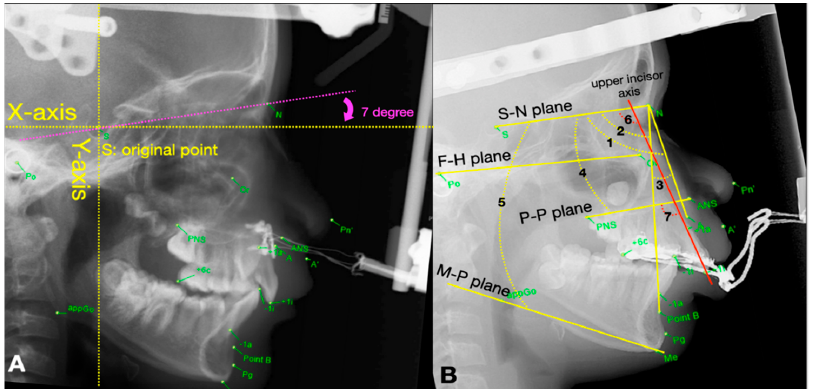
Figure 3. The lateral cephalograms of ( A ) Bone-borne RED with transcutaneous wire system present with cephalometric landmarks in relation to the X-Y coordinate system ( B ) traditional Tooth-borne RED with intra-oral splint, present with reference lines: S-N plane (S-N, sella-nasion plane); F-H plane (Po-Or, Frankfort plane); P-P plane (PNS-ANS, palatal plane); M-P plane (Go-Me, mandibular